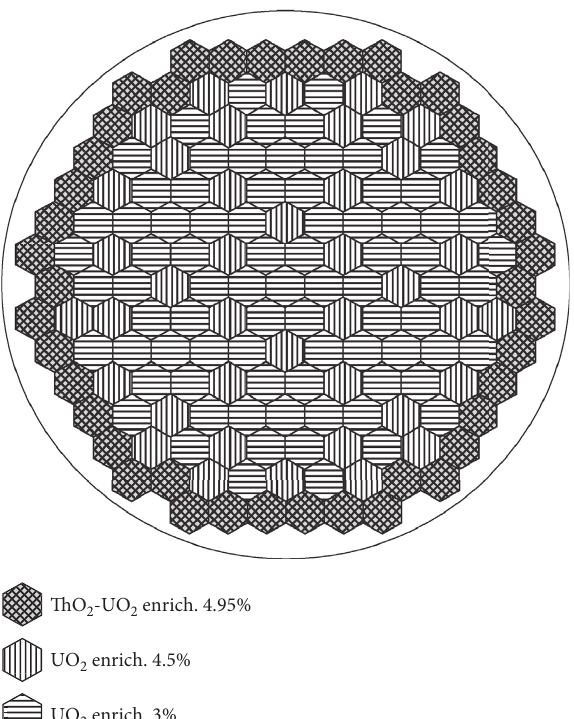
Table 3: TNCs values, for uranium-235, for ENDF/B-VII.1, B-VIII, and standards